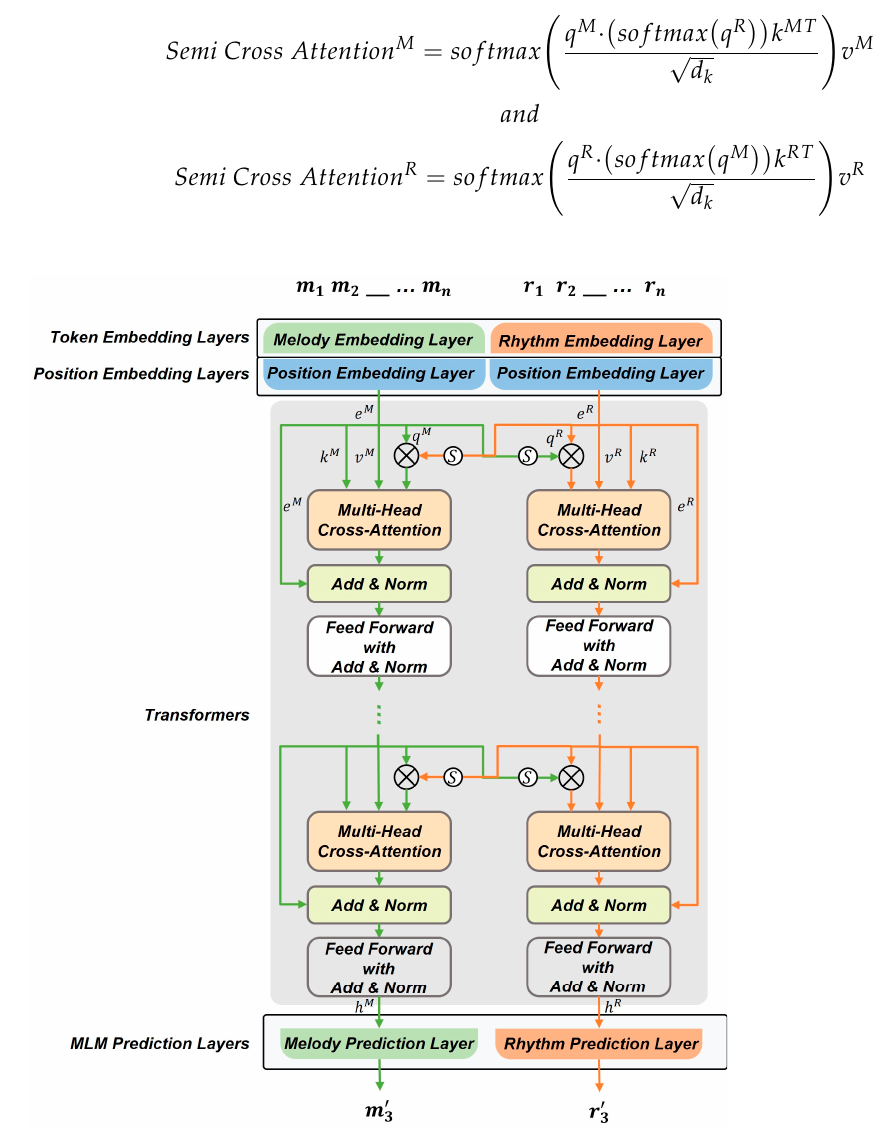
Figure 2. Pipeline of pre-training of MRBERT.